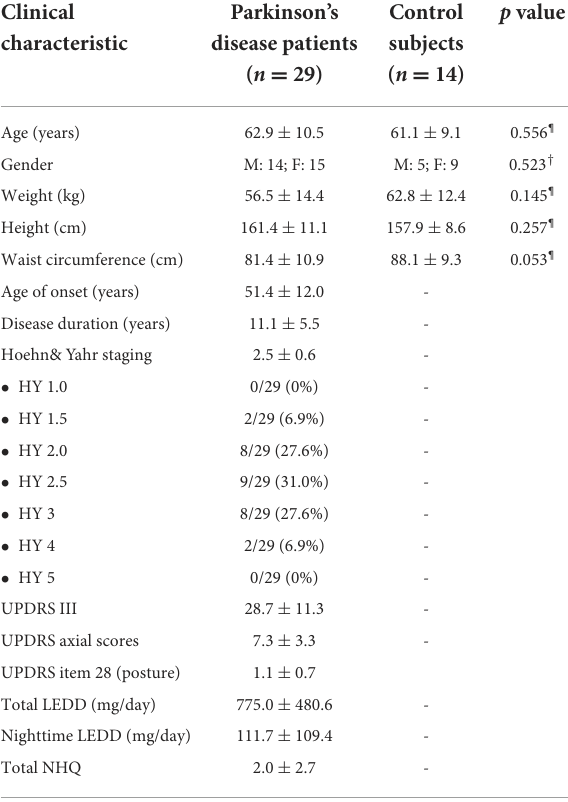
TABLE 1 Clinical demographics of patients with Parkinson’s disease and control subjects.